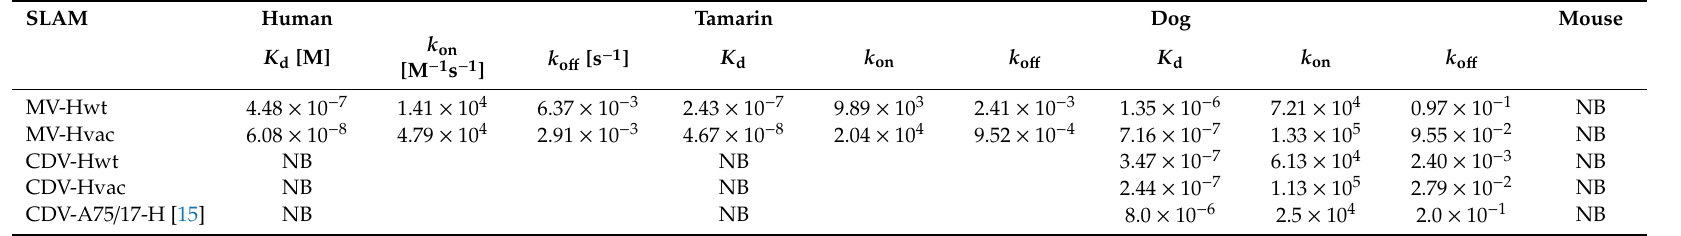
Table 1. Kinetic constants for the binding of H and SLAM